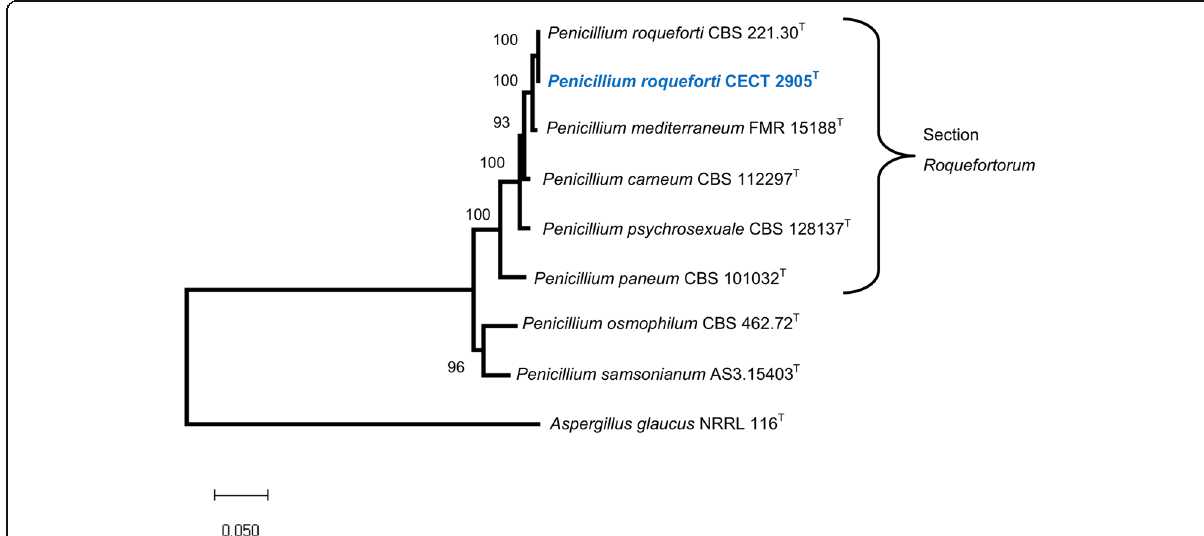
Fig. 1 Phylogenetic tree obtained after Maximum Likelihood analysis of the genome sequence of Penicillium roqueforti CECT 2905 T and related species. The analysis was done as detailed in the Materials and methods section. Bootstrap support values (>50%) are shown at the nodes (bootstrap iterations=1000). The tree was rooted using combined BenA , CaM and RPB2 regions from Aspergillus glaucus NRRL 116 T . T =ex-type